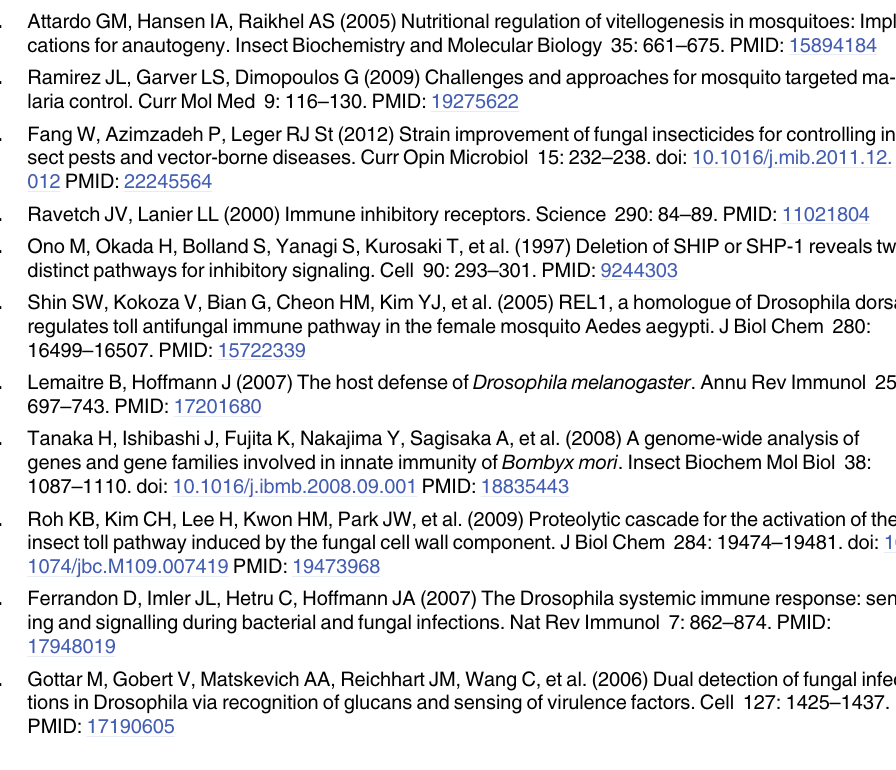
S3 Table. Repertoire of immune genes changed (fold change (cid:1) 1.5) in the CLSP2 dsRNA- treated mosquitoes with B . bassiana challenge (iCLSP2Bb). S4 Table. Up-regulated immune genes were shown in experimental conditions, iLucBb, iCLSP2 and iCLSP2Bb. S5 Table. RNAi for putative genes involved in the CLSP2-modulated antifungal immune response. S6 Table. Primers used for real-time RT-PCR, RT-PCR, dsRNA synthesis, and protein ex- pression. S7 Table. The list of accession numbers/ID numbers for genes and proteins used in this